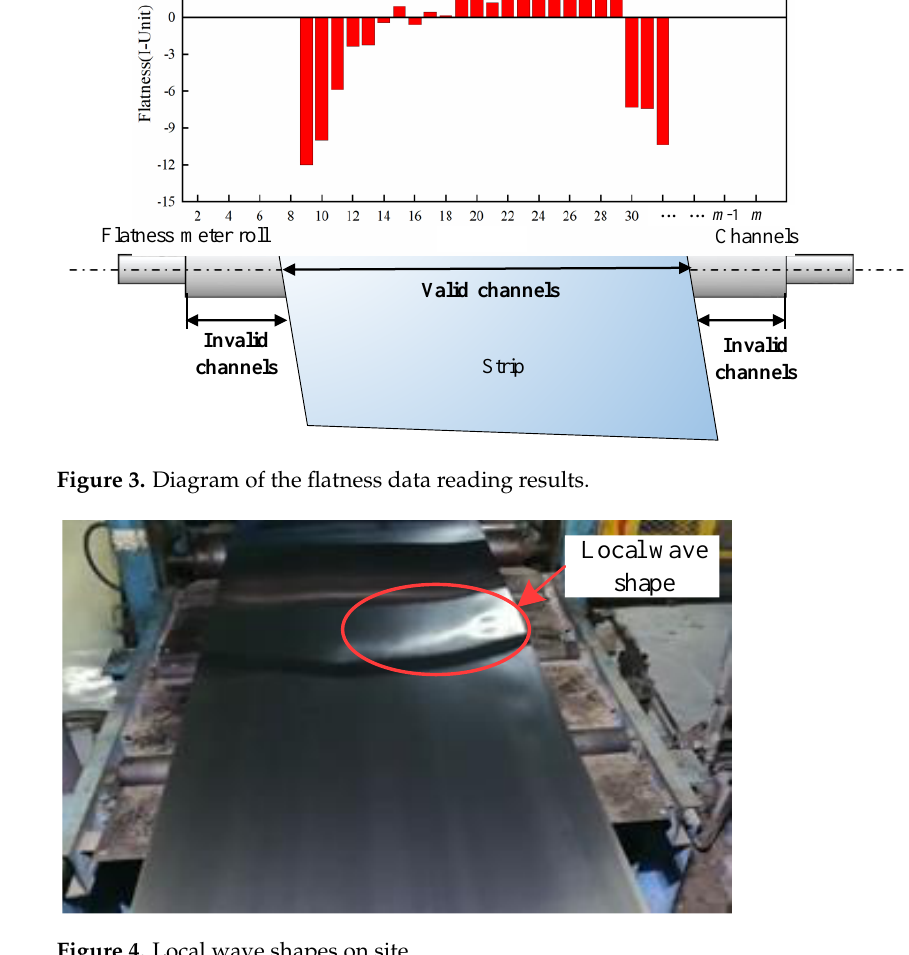
Figure 4. Local wave shapes on